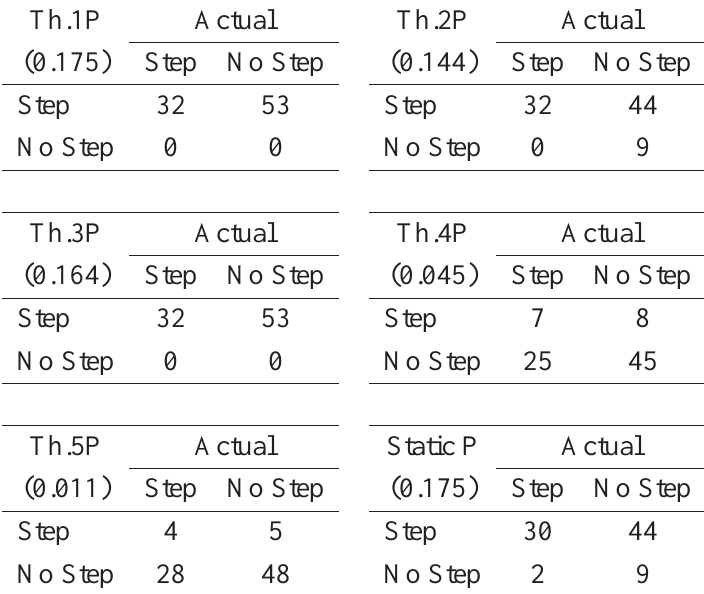
Table 4 . 2 × 2 contingency tables for each threshold for posterior perturbations. The values in the brackets indicate the step thresholds.